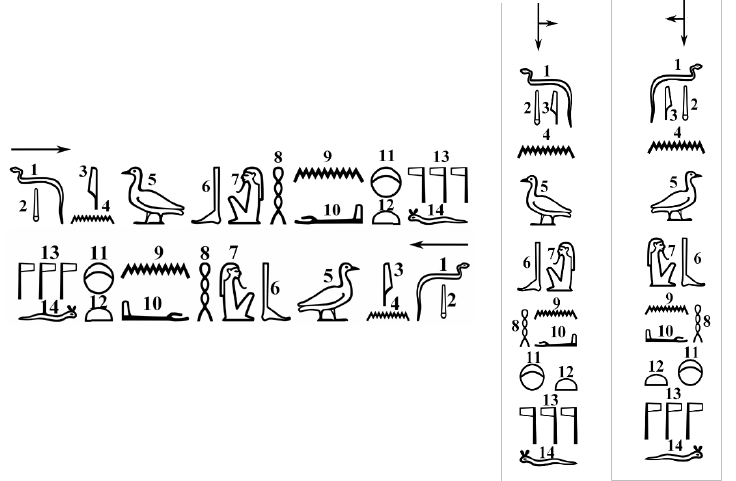
Figure 1. Various reading directions of ancient Egyptian